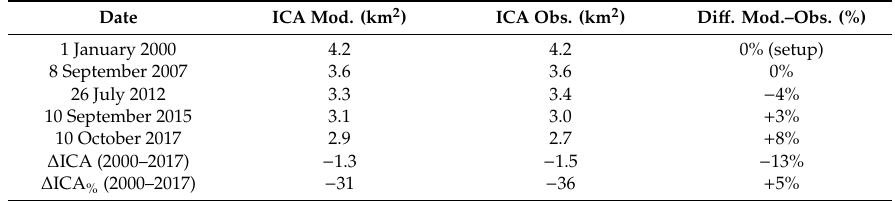
Table 5. Validation of the modelled ice covered area from Poly-Hydro at five dates during 2000–2017.